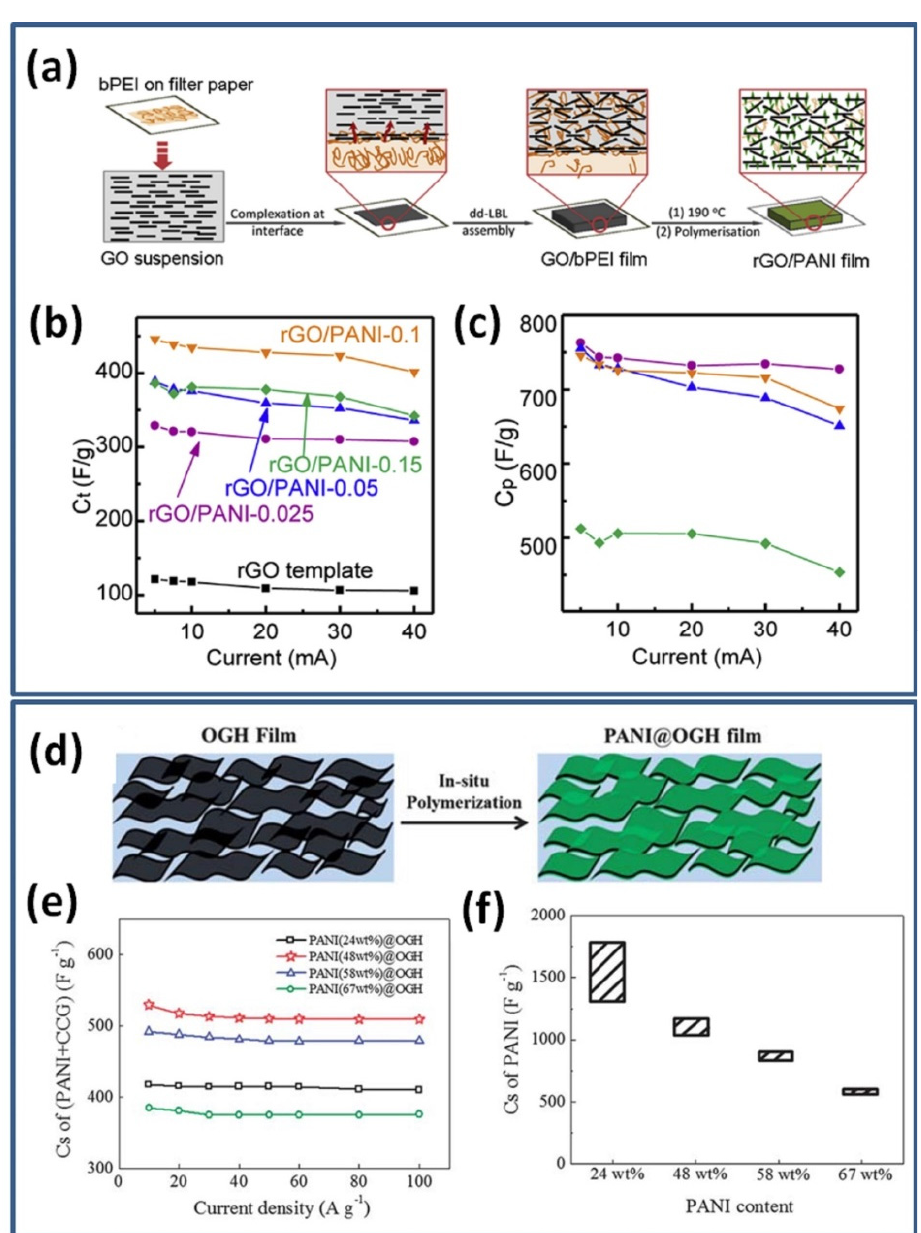
Figure 2. Schematic of preparing RGO/PANI composite film ( a ). Specific capacitances of RGO/PANI electrodes ( b ) and capacitance of PANI in RGO/PANI electrodes ( c ) at various charge/discharge currents (Reprinted from [39], Copyright 2017, with permission from Elsevier). Schematic of the PANI@OGH film formation ( d ). Specific capacitance of PANI@OGH films against the total weight of PANI and chemically converted graphene (CCG) ( e ), and specific capacitance of PANI against its own weight ( f ) at a current density of 10 A/g (Reprinted from [40] with permission of RSC Publishing). The highest specific capacitance among used aniline concentrations from 0.025 to 0.15 M was calculated to be of 438 F/g based on the weight of both RGO and PANI (designated as C t in Figure 2b). However, due to low capacitance of pristine RGO, Hong et al. decided to deduct the capacitance contributed by RGO from the whole capacitance and compared the remaining capacitances, which could be attributed to PANI (designated as C p in Figure 2c). Obtained in this way specific capacitance increased significantly up to 763 F/g and did not show strong dependency on PANI content until very high values leading to structural changes such as aggregation